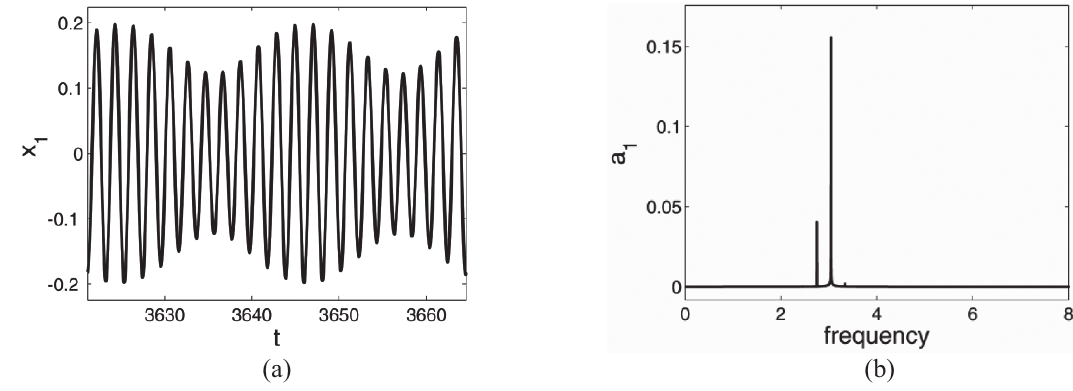
Fig. 3. Time series (a) and fast Fourier transform (b) for quasi-periodic beam motion; x 0 = 0.01, Ω = 2.75.